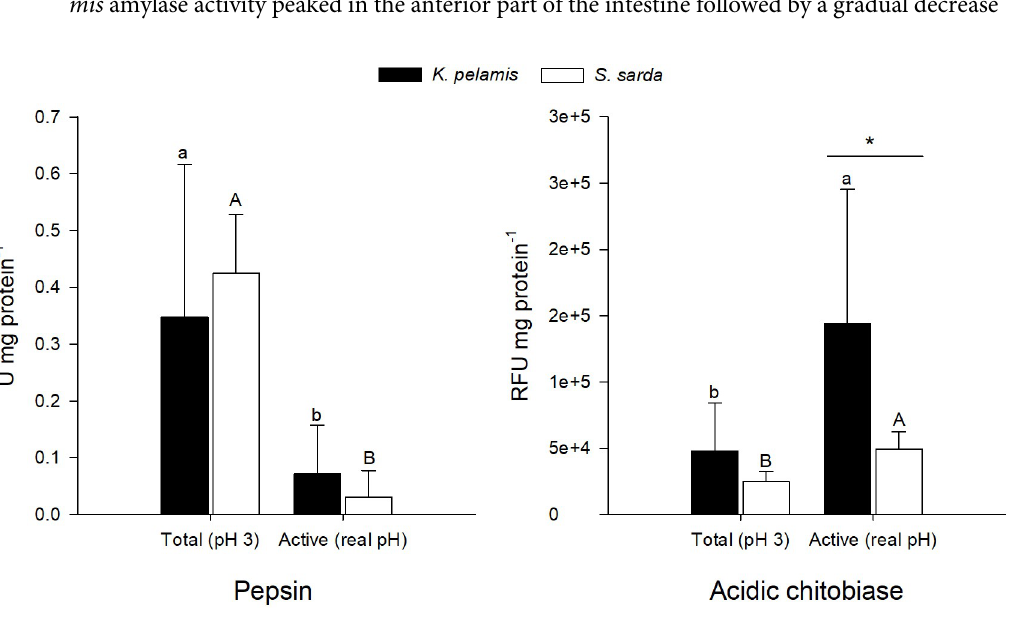
Fig 4. Acidic digestive enzymes activity levels. Total and active enzymatic levels of pepsin and acidic chitobiase in Katsuwonus pelamis (black dots) and Sarda sarda (white dots) stomachs. Data are presented as mean ± SD ( n = 10). Different lowercase letters (a,b) represent statistical differences between digestive organs of S . sarda , while different capital letters (A, B) represent statistical differences between digestive organs of K . pelamis (P < 0.05). Asterisks represent statistical differences between species (P < 0.05). Absence of asterisk indicates no statistical difference between species (P > 0.05).